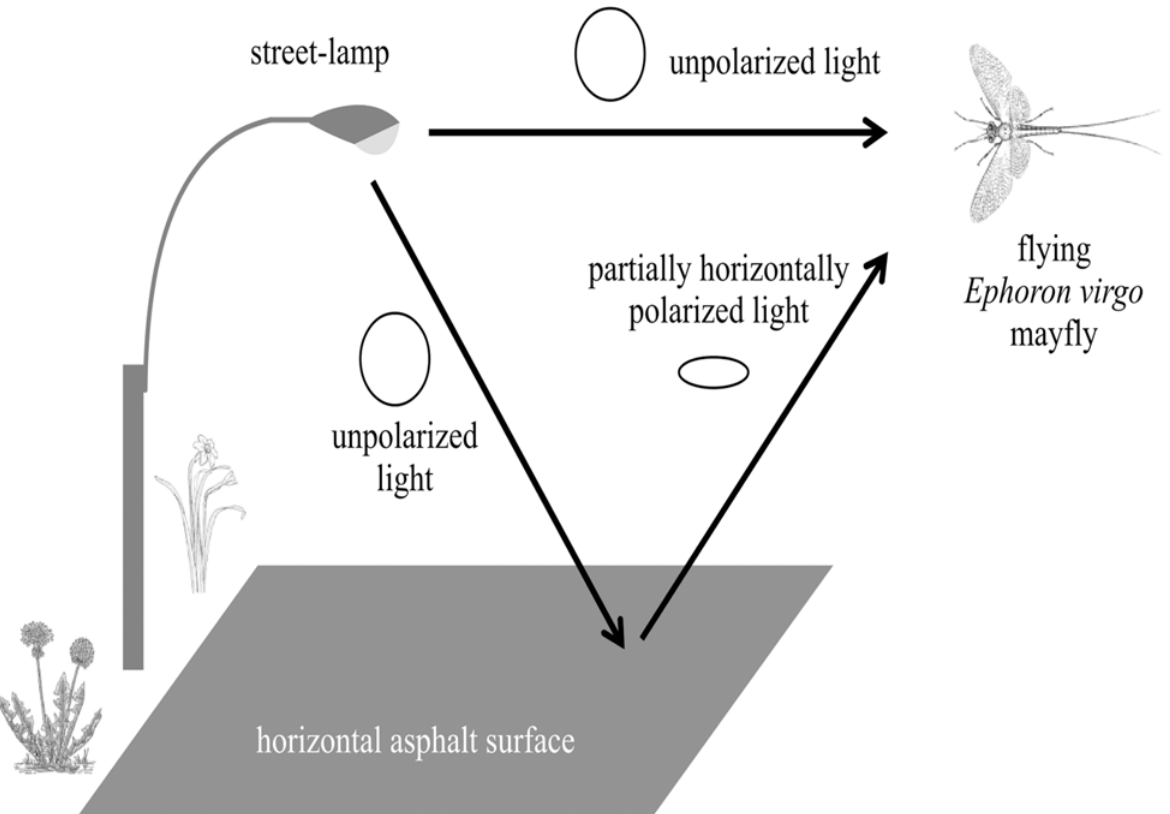
Fig 1. Nocturnal artificial sources of unpolarized and horizontally polarized light interact to attract polarotactic insects. Unpolarlized light sources (e.g., street-lamps) may attract perching or flying nocturnal polarotactic insects directly ( Ephoron virgo mayfly illustrated). Alternatively, unpolarized light from the street-lamp can become horizontally polarized through reflection from smooth, dark surfaces like asphalt, simulating the appearance of a water